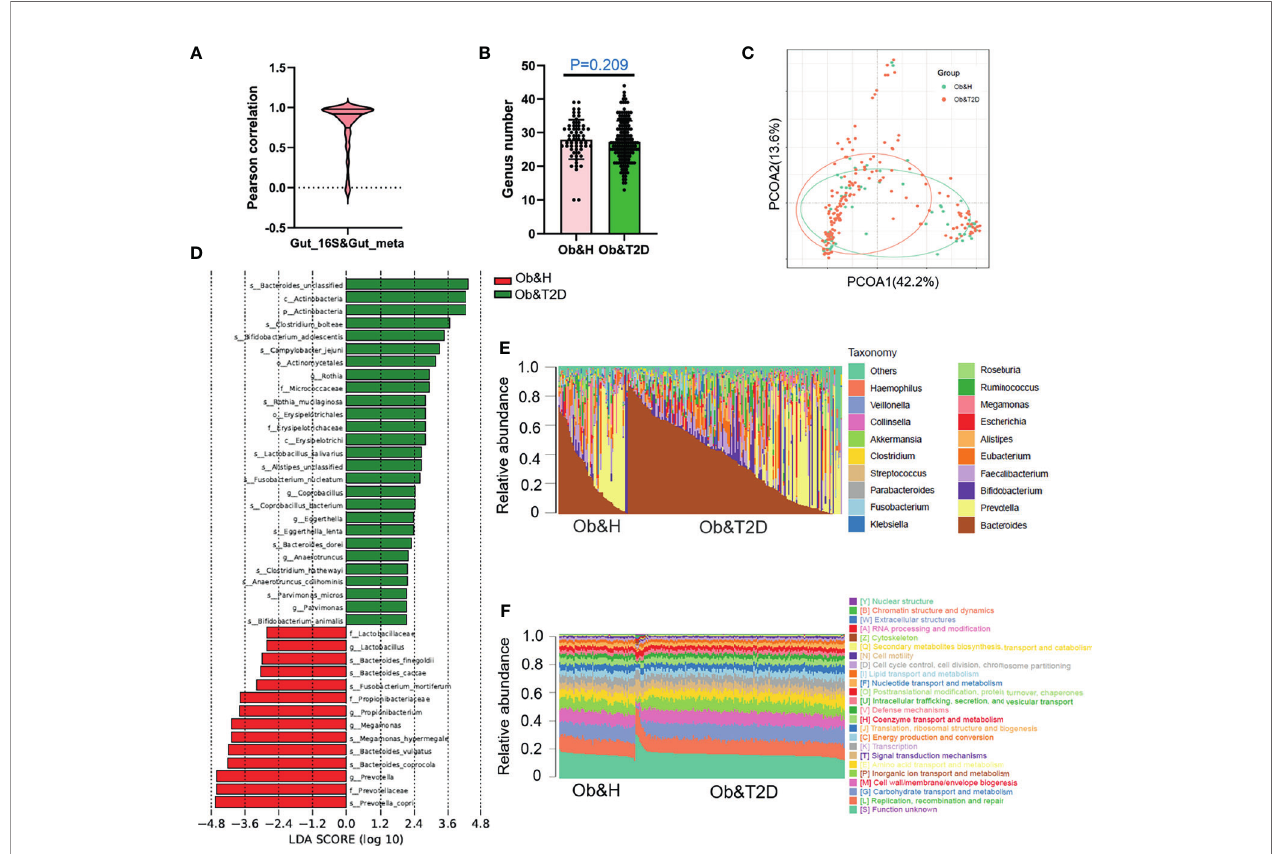
FIGURE 3 | Gut microbiota divergence analysis in obese and healthy (Ob&H) and obese and type 2 diabetes (Ob&T2D) based on metagenomic sequencing data. (A) Violin plot displaying Pearson correlation between gut 16S rRNA gene sequencing and metagenomic sequencing data. (B) Estimate of richness analysis between the two groups at the genus level. Data are shown as means ± SD. (C) Principal coordinate analysis (PCoA) of the microbiota based on the Bray – Curtis distance metrics for Ob&H and Ob&T2D. ANOSIM, R = 0.107, P = 0.001. (D) Genus-level taxonomic abundances for gut metagenomic sequencing data. The top 20 abundant genera are annotated in the panel legend. The samples are ordered according to decreasing relative abundance of Bacteroides in the Ob&H and Ob&T2D groups. (E) Predicted eggNOG orthologous functional annotations of gut microbial unique genes from metagenomic data. (F) The linear discriminant analysis (LDA) scores for the gut bacterial taxa are differentially abundant between Ob&H and Ob&T2D. Red bars with LDA score greater than 2 indicate that the taxa were enriched in Ob&H, and green bars with LDA score greater than 2 indicate that the taxa were enriched in